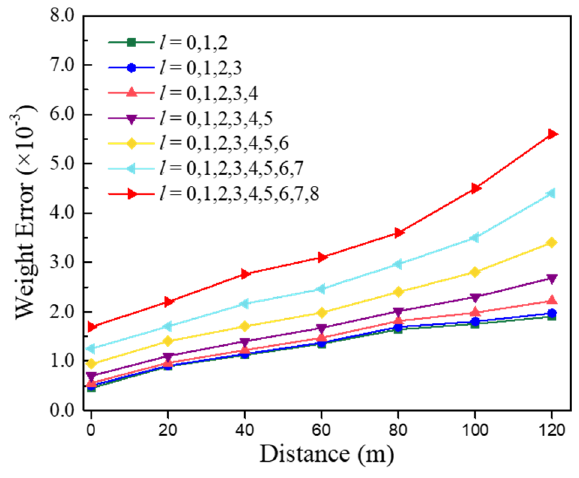
Figure 6. The relation between mode weight error and distance.